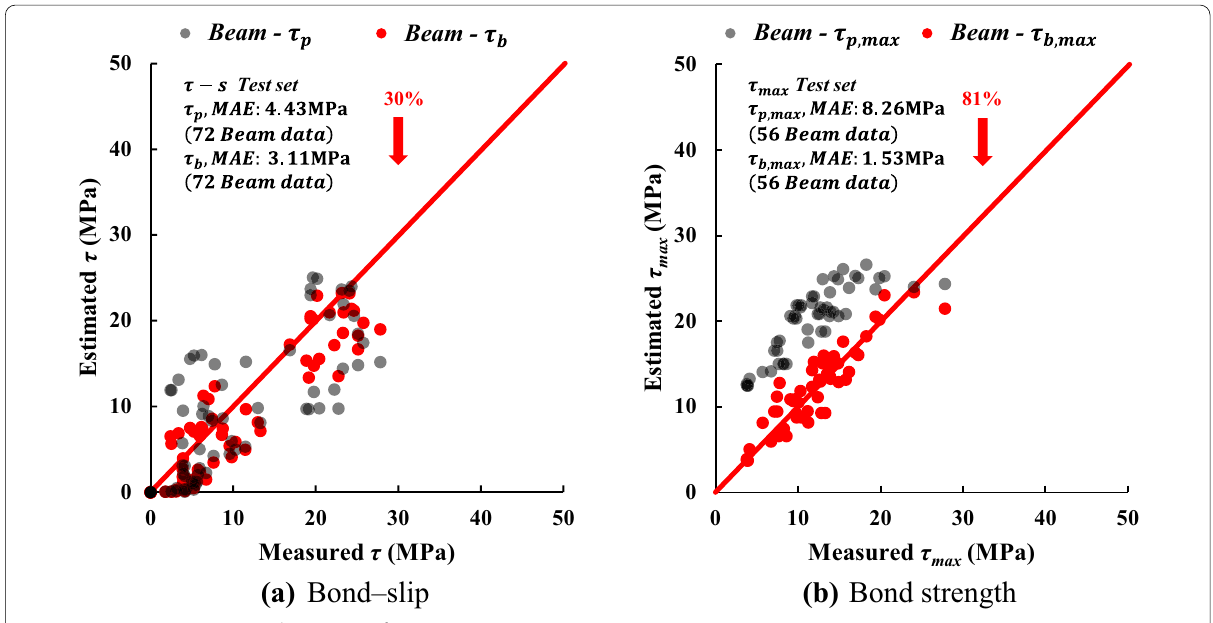
Fig. 11 Accuracy improvement by mapping function.